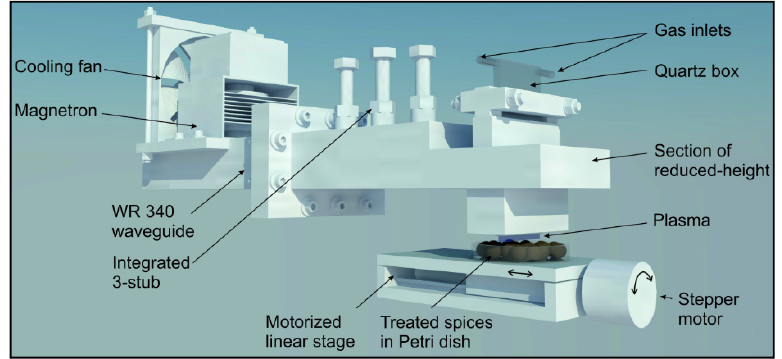
Figure 1. Setup for microwave plasma treatment of selected spices.